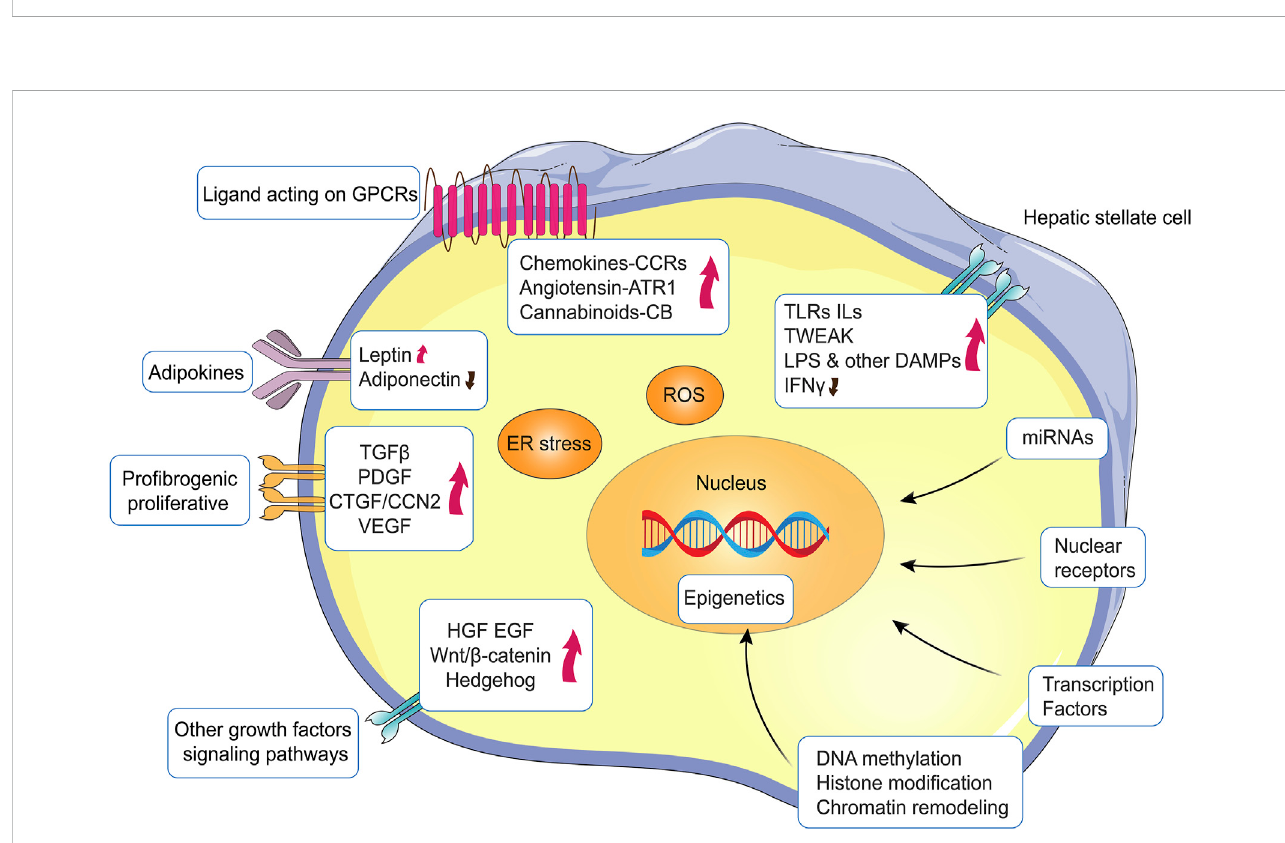
FIGURE 3 Major signaling pathways, molecules and mechanisms regulating HSC activation. HSC activation is regulated by a multitude of pathways and signaling molecules or events that can either sustain or inhibit HSC activation and subsequent proliferative and/or pro fi brogenic responses.